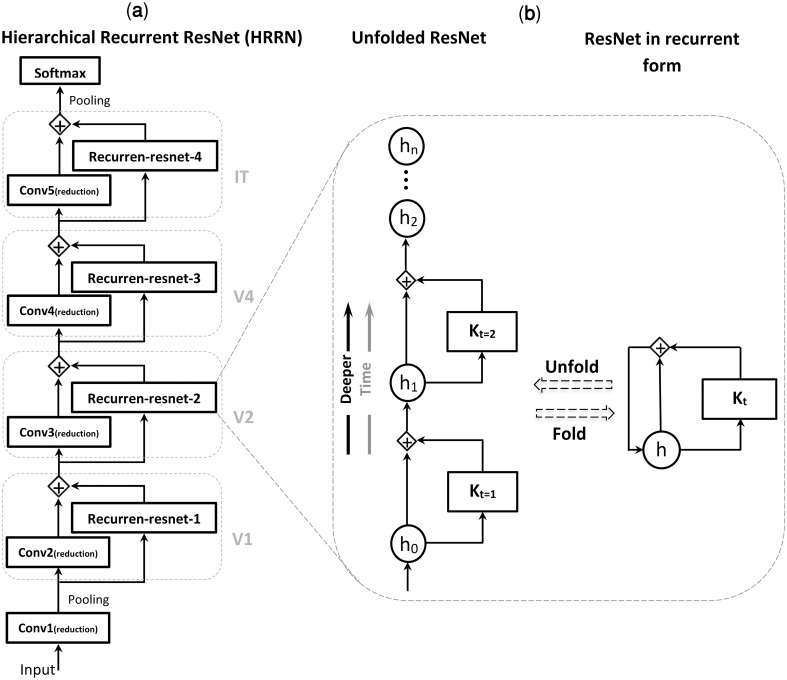
Hierarchical recurrent ResNet (HRRN) in unfolded form is equivalent to an ultra-deep ResNet.(a) A hierarchy of convolutional layers with local recurrent connections. This hierarchical structure models the feedforward and local recurrent connections along the hierarchy of ventral visual pathway (e.g. V1, V2, V4, IT). (b) Each recurrent unit is equivalent to a deep ResNet with arbitrary number of layers depending on the unfolding depth. ht is the layer activity at a specific time (t) and Kt represents a sequence of nonlinear operations (e.g. convolution, batch normalization, and ReLU). [see [63] for more info].